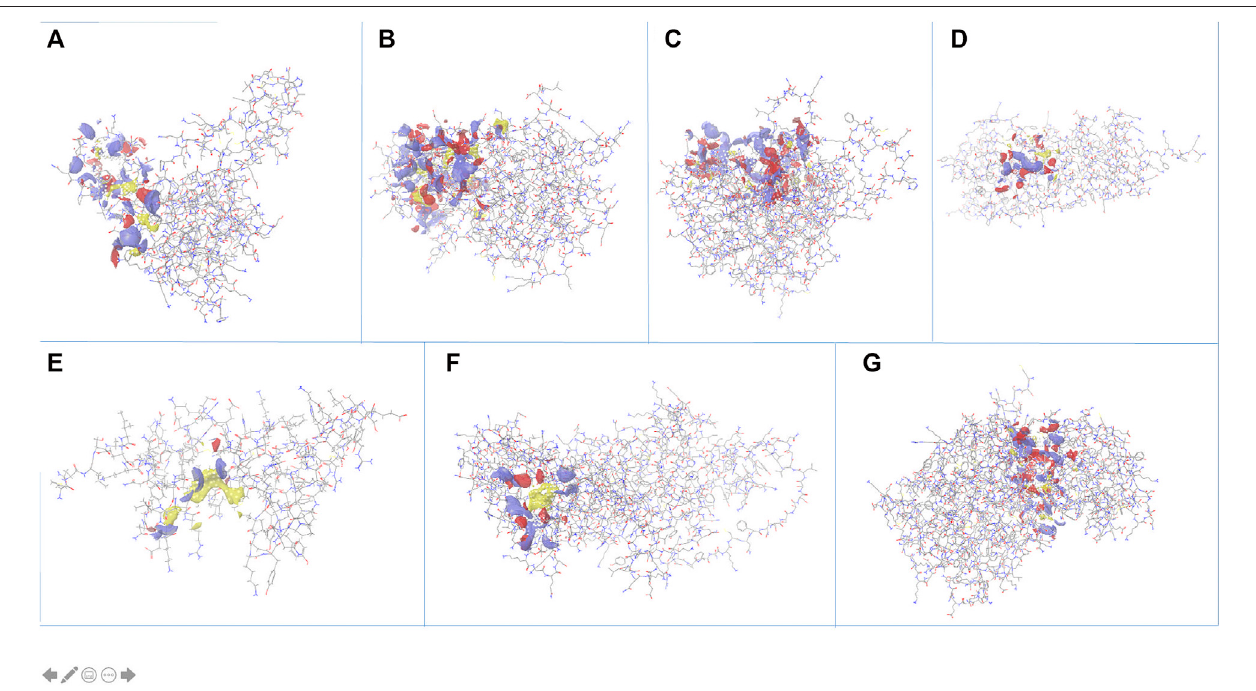
FIGURE4| Identi fi cationofactivesitepockets(highlightedasclouds)fortheshortlistedproteins (A) PF3D7_1368300, (B) PF3D7_1204500, (C) PF3D7_1308500, (D) PF3D7_1438600, (E) PF3D7_0418400, (F) PF3D7_1442800 and (G) PF3D7_1402000.